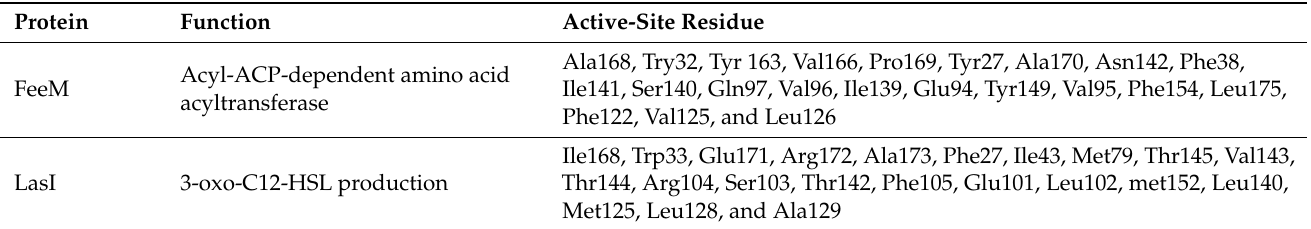
Table 1. Proteins involved in the AHL substrate recognition, biological function, and their active-site residues. Protein